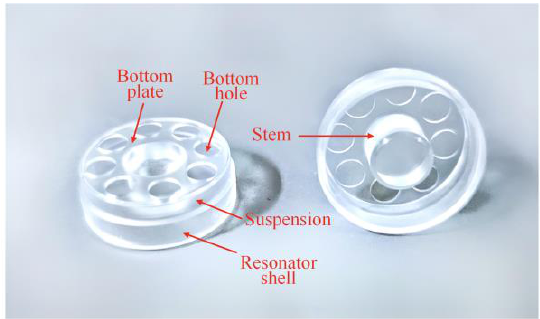
Figure 2. The description of the cylindrical fused silica resonator.